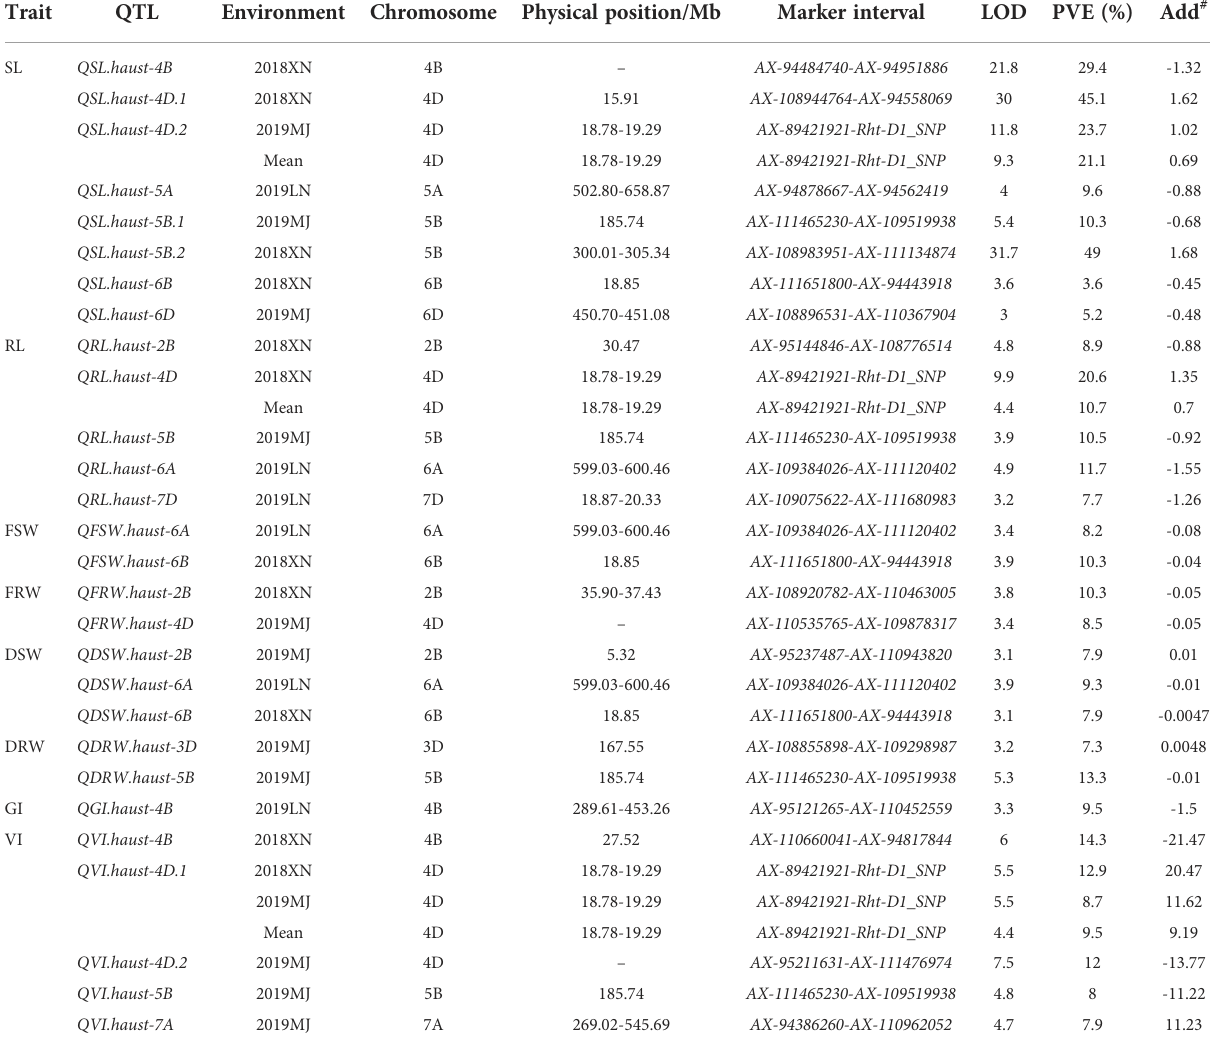
TABLE 3 QTL mapping for seed vigor related traits in the Yangmai 16/Zhongmai 895 DH population. Trait